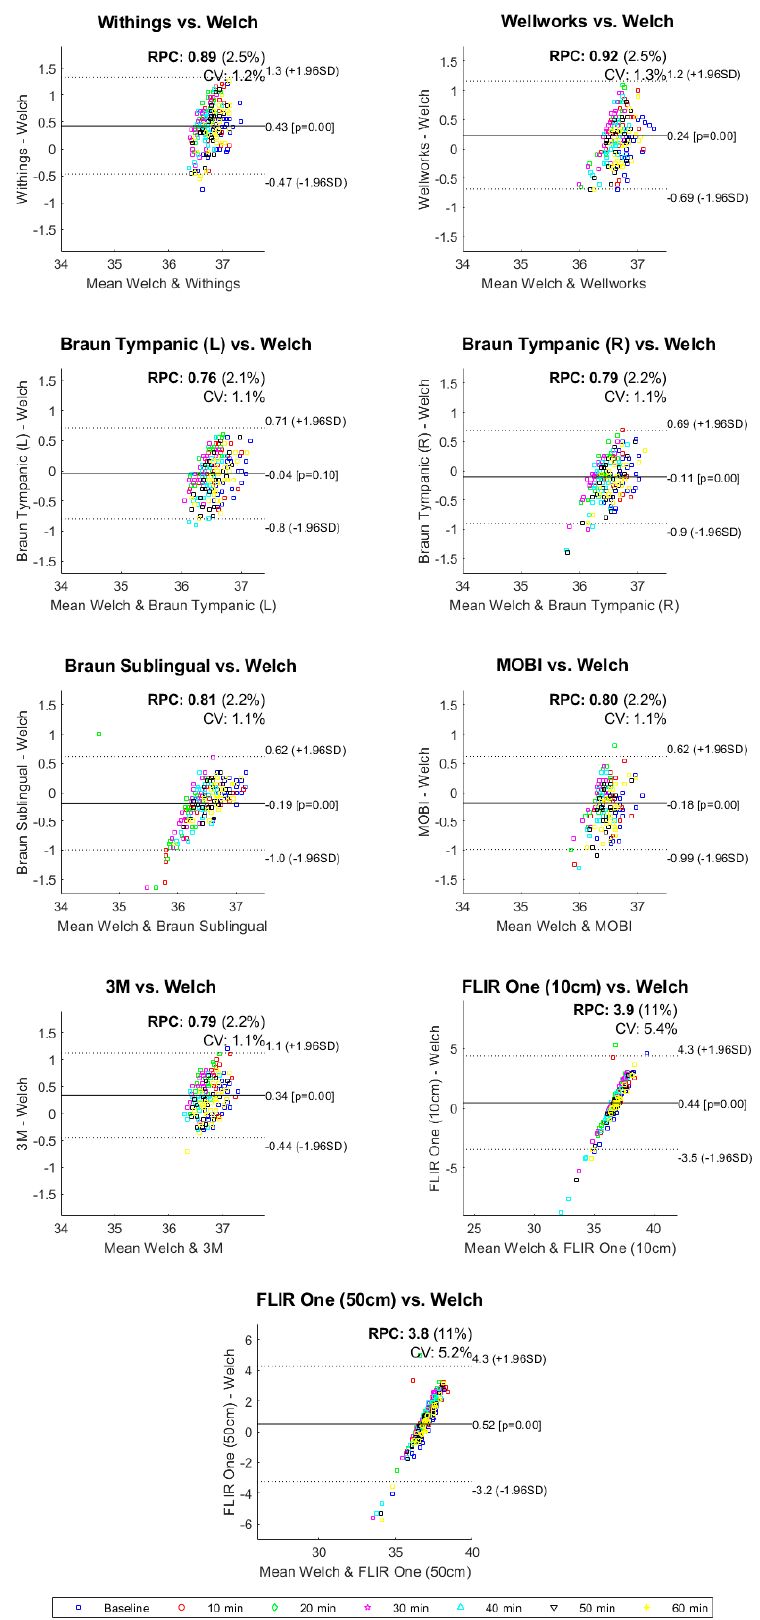
Figure 5. Bland − Altman plots for all thermometers vs. the gold standard.